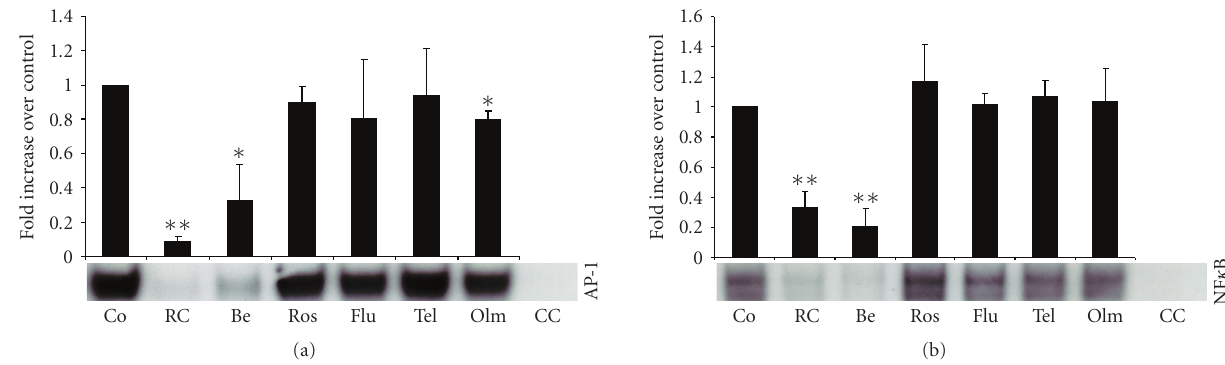
Figure 5: Direct comparison of cholesterol synthase inhibitors, angiotensin receptor blockers, total extract of Rhizoma coptidis (dilution 1 : 5), and berberine (dilution 10 − 4 mol) on transcription factor activity of AP-1 (a) and NF κ B (b). Exposure time of all substrates was 240min. AP-1: activated protein-1, NF κ B: nuclear factor κ B, Co: LPS-stimulated control cells, RC:Rhizoma coptidis , Be: berberine, Ros: 10 − 6 mol rosuvastatin, Flu: 10 − 6 mol fluvastatin, Tel: 10 − 5 mol telmisartan, Olm: 10 − 5 mol olmesartan, and CC: cold competition. ∗ P < . 005, ∗∗ P < .